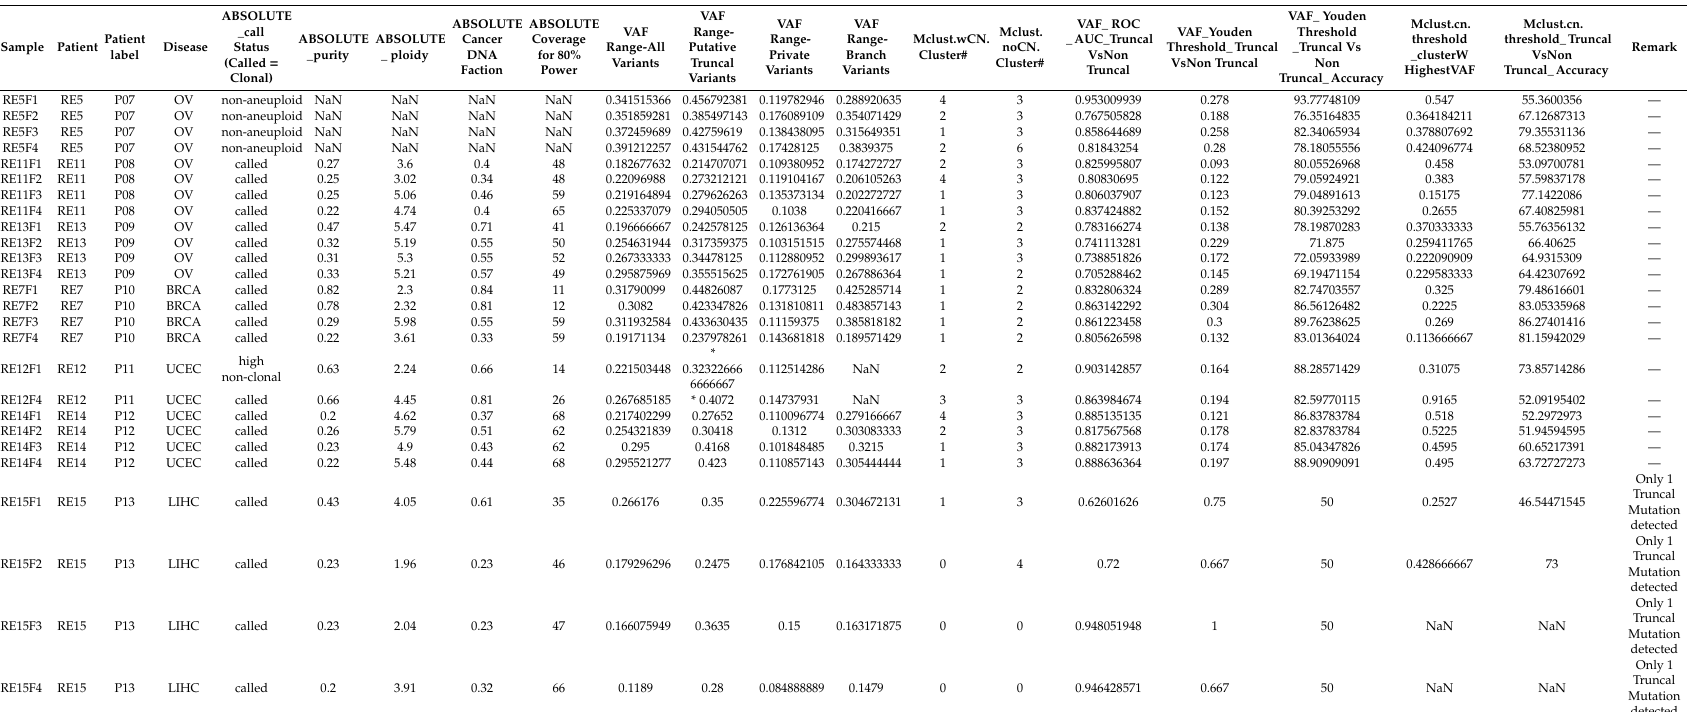
Sample Patient Patient label